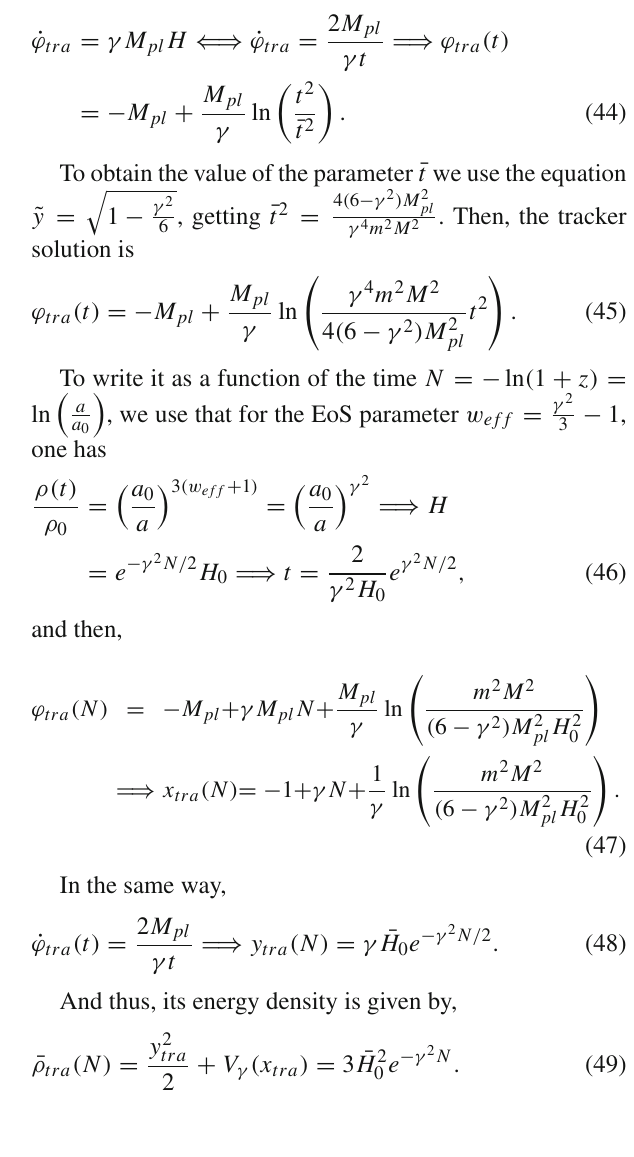
Fig. 6 In the left panel we show the evolution of the density parame- ter (cid:13) for matter (blue curve), radiation (red curve) and the scalar field (black curve). In the right panel we present the evolution of the effec- tive EoS w ef f . For the numerical simulation we fix γ = 1, reheating temperature T rh = 100 TeV and ¯ M = 0 . 0167. At the present time